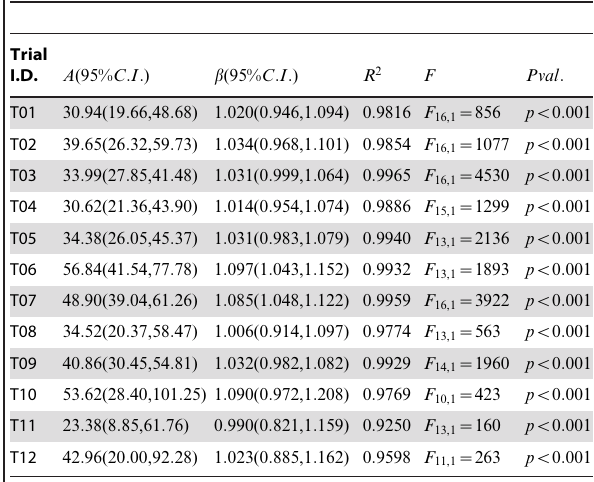
Table 1. Fit of eq. 4 parameters from individual replicates; pheromone evaporation is not assumed.